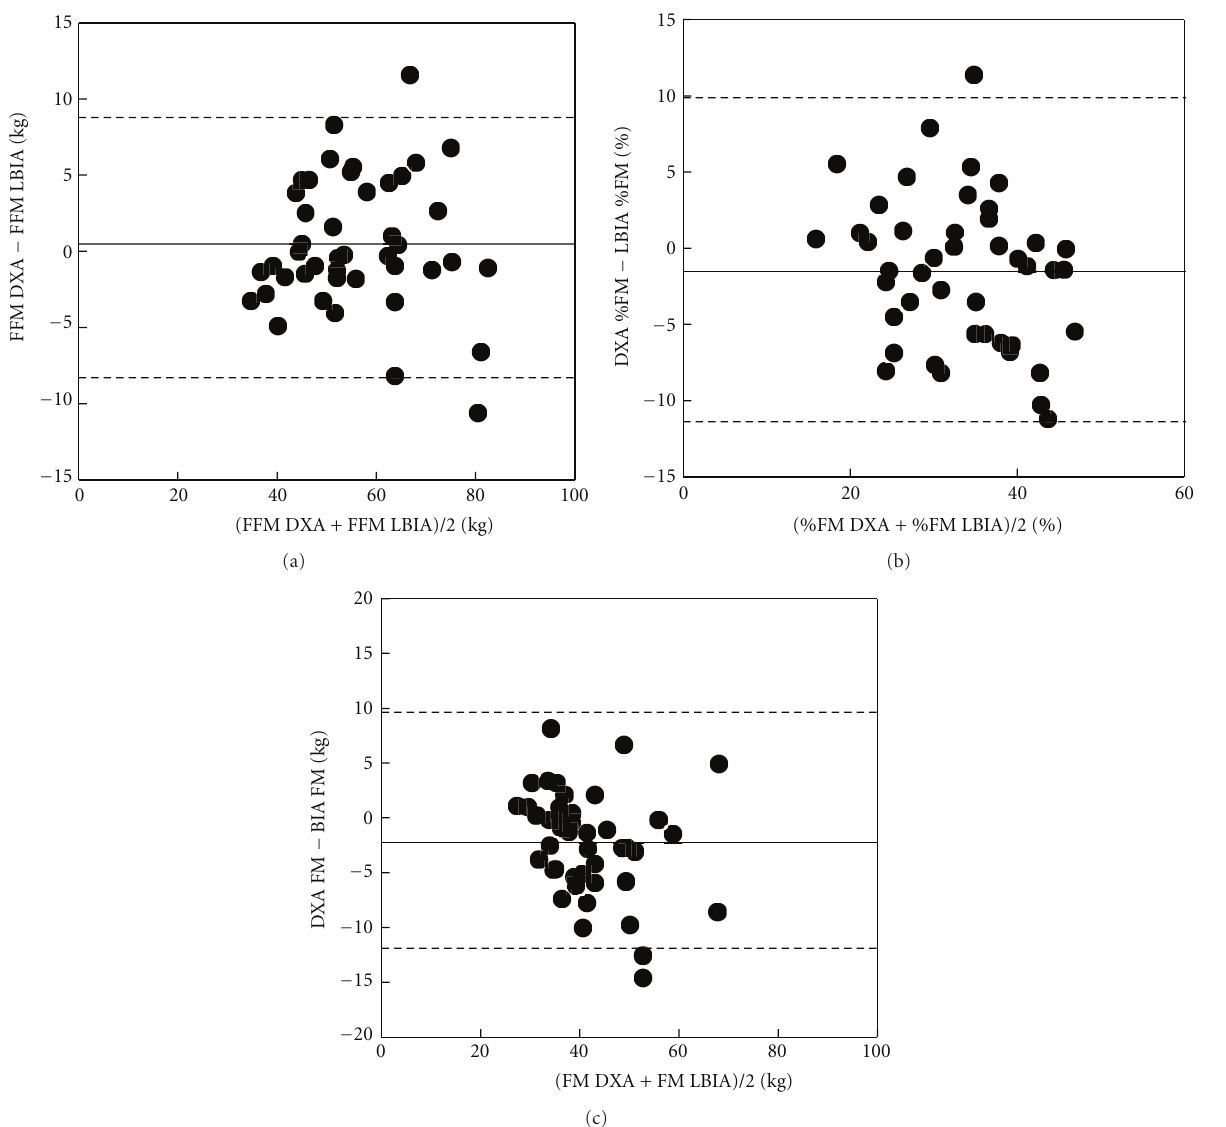
Figure 2: Bland-Altman plots comparing the FFM (a), %FM (b), and FM (c) assessed by LBIA and that assessed by DXA(before intervention) DXA: dual X-ray absorptiometry; LBIA: leg-to-leg bioelectrical impedance analysis; FFM: fat free mass; %FM: percentage body fat; FM: fat mass. The middle solid line represents the mean di ff erence between LBIA and DXA; the upper and lower dotted lines represent 95% limits of